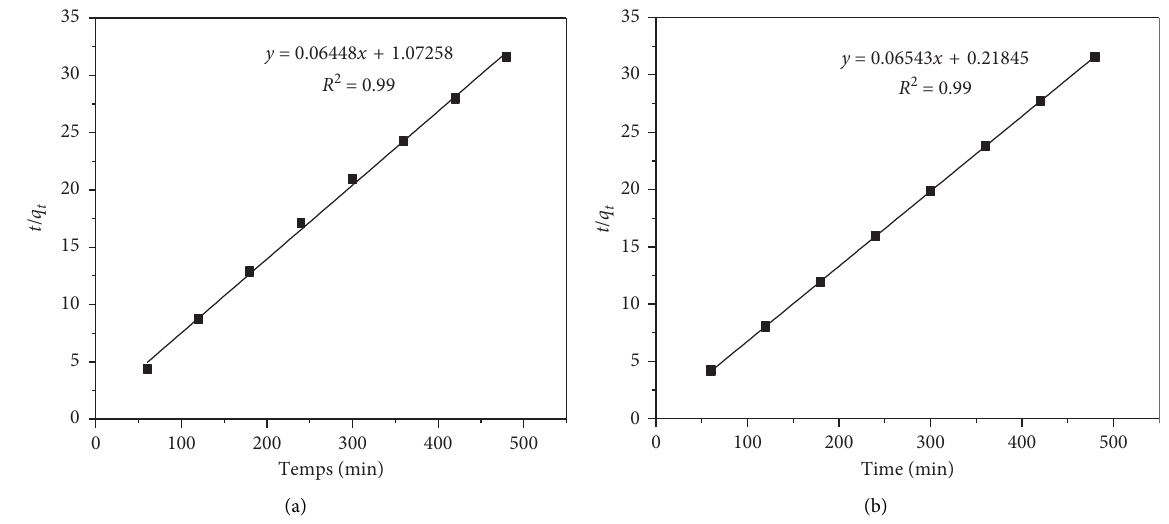
Figure 8: Plots of the pseudo-order kinetics of MB dye adsorption on the geopolymer (a) without UV and (b) with UV.